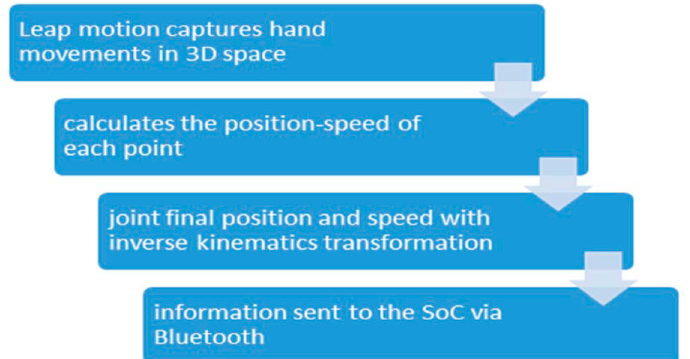
11 of 17 Figure 11. Leap software’s distance of shoulder, elbow, claw points from sensor.